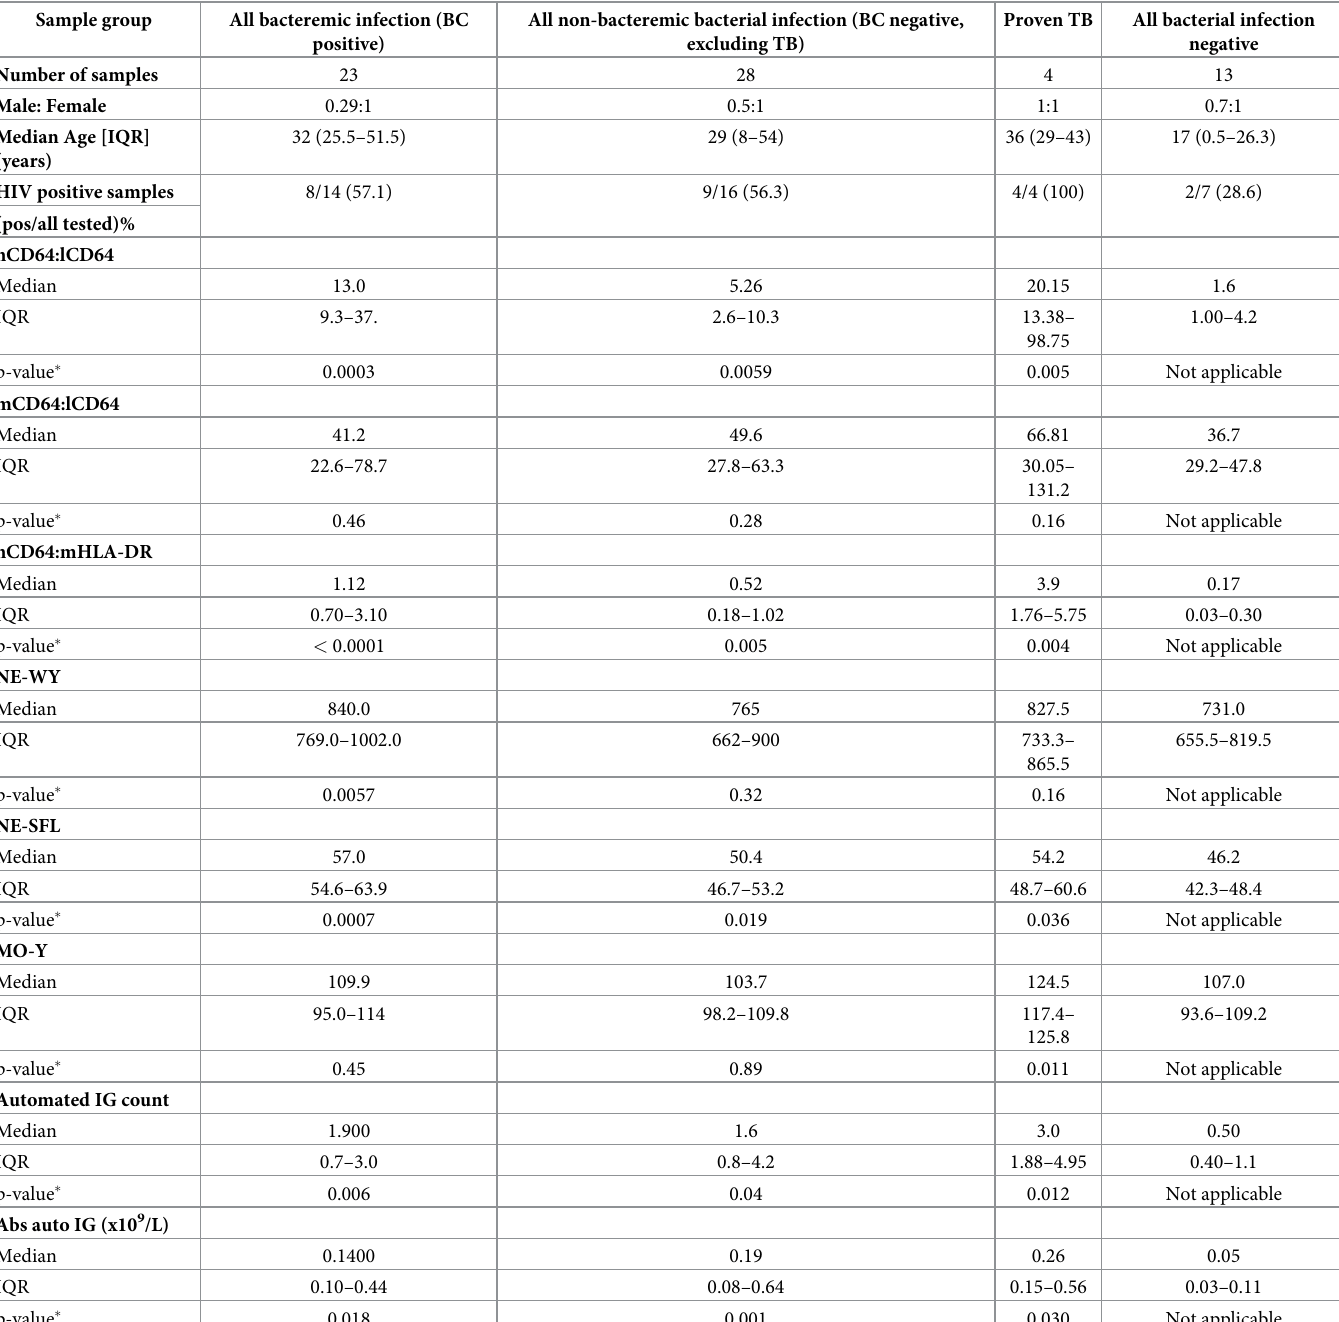
Table 1. Biometrics and EDP data of all samples with unequivocal